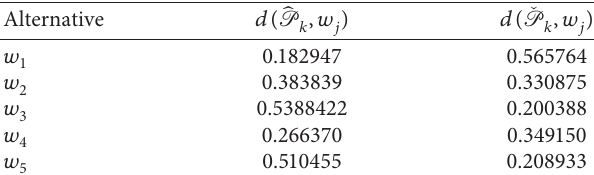
Table 49: Normalized Euclidean distance from ideal solution. Alternative